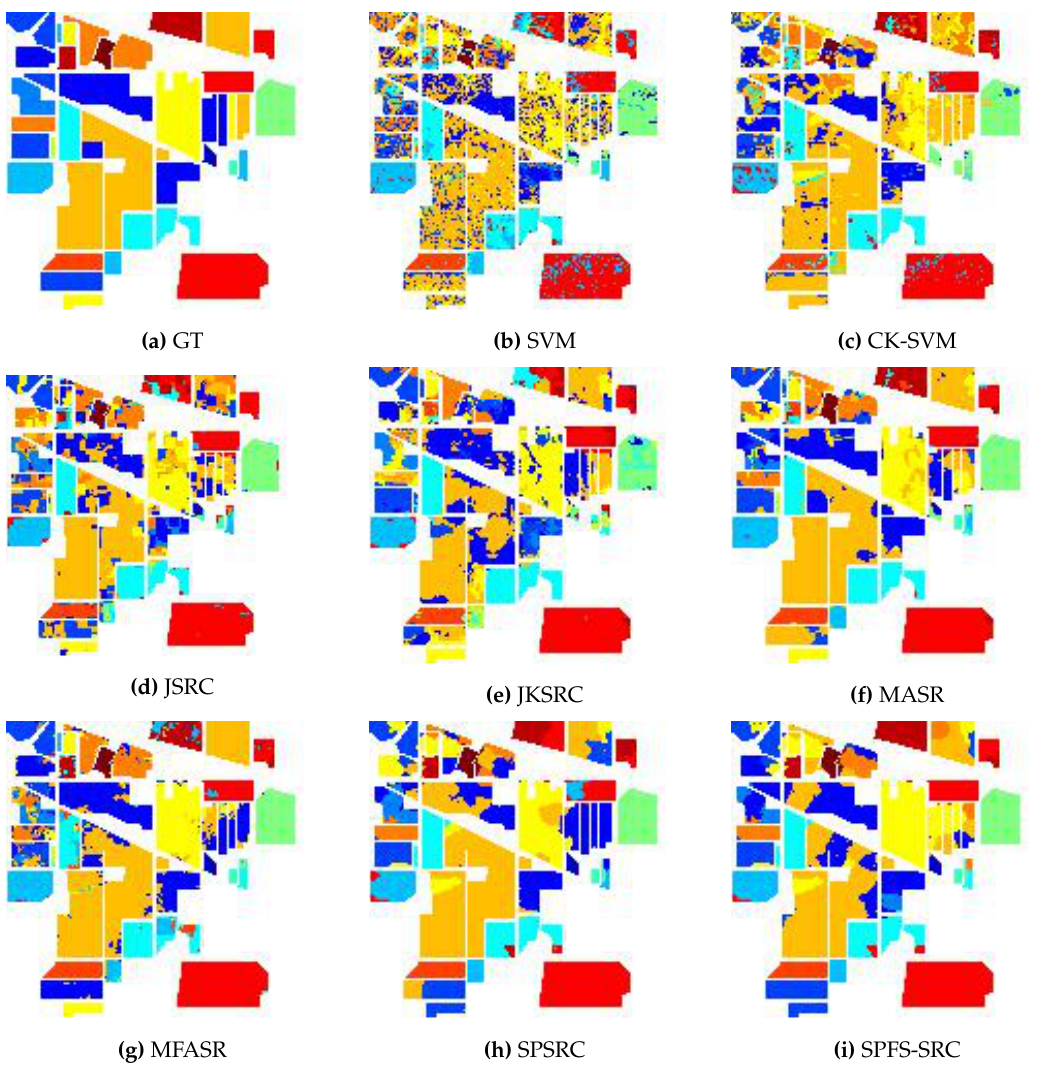
Figure 7. The classification map of the Indian Pine dataset. ( a ) the Ground Truth (GT), ( b ) SVM, ( c )